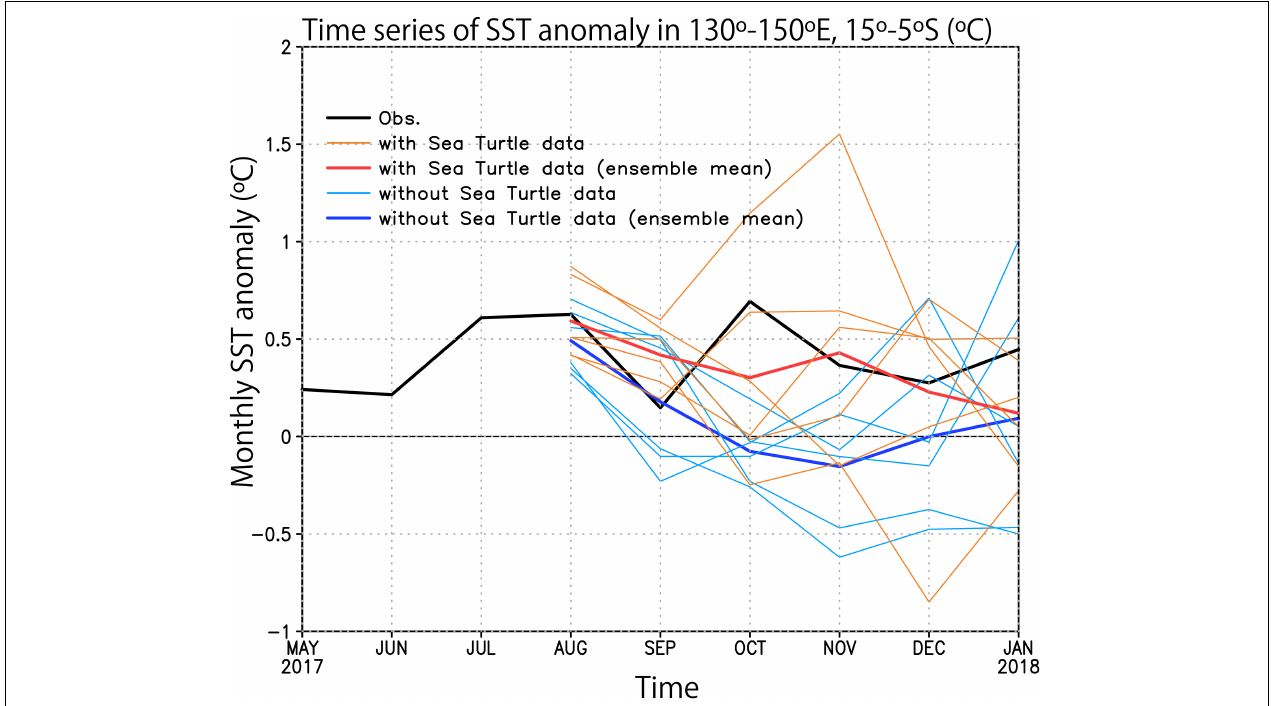
FIGURE 6 | Monthly SST anomaly averaged in 130 ◦ –150 ◦ E, 15 ◦ S–5 ◦ S during the latter half of 2017 ( ◦ C) from the observational data of NOAA OISSTv2 (black) and the prediction from the August 1, 2017, initialization with the six-ensemble by the Ctl_forecast (thin right blue, each ensemble member; thick blue, ensemble mean) and the six-ensemble by the wTurtle_forecast (thin orange, each ensemble member; thick red, ensemble